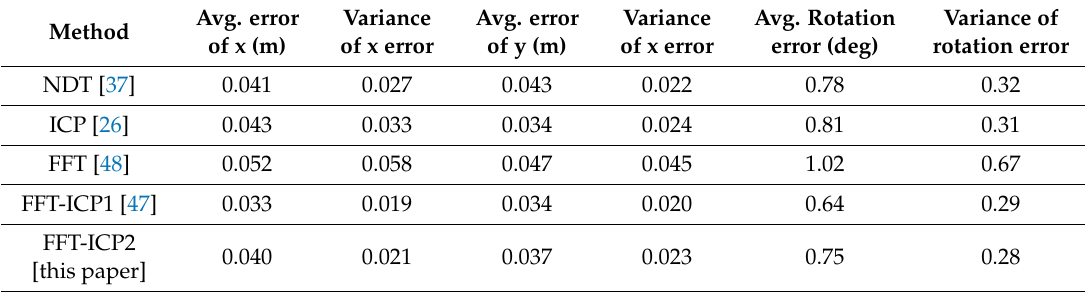
Table 2. Results of the matching accuracy.